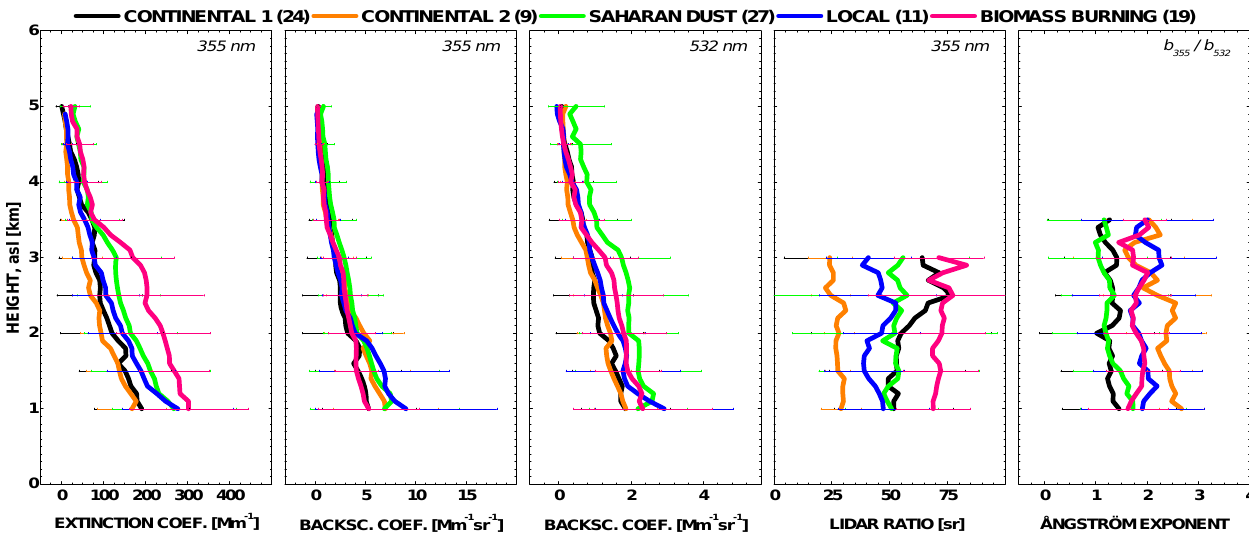
Fig. 2. Vertical profiles of aerosol optical properties at Thessaloniki, Greece for each aerosol type for the period under study (2001–2007). Table 1. Lidar-derived mean aerosol optical properties at Thessaloniki, Greece averaged for each aerosol type for the time period between 2001 and 2007.